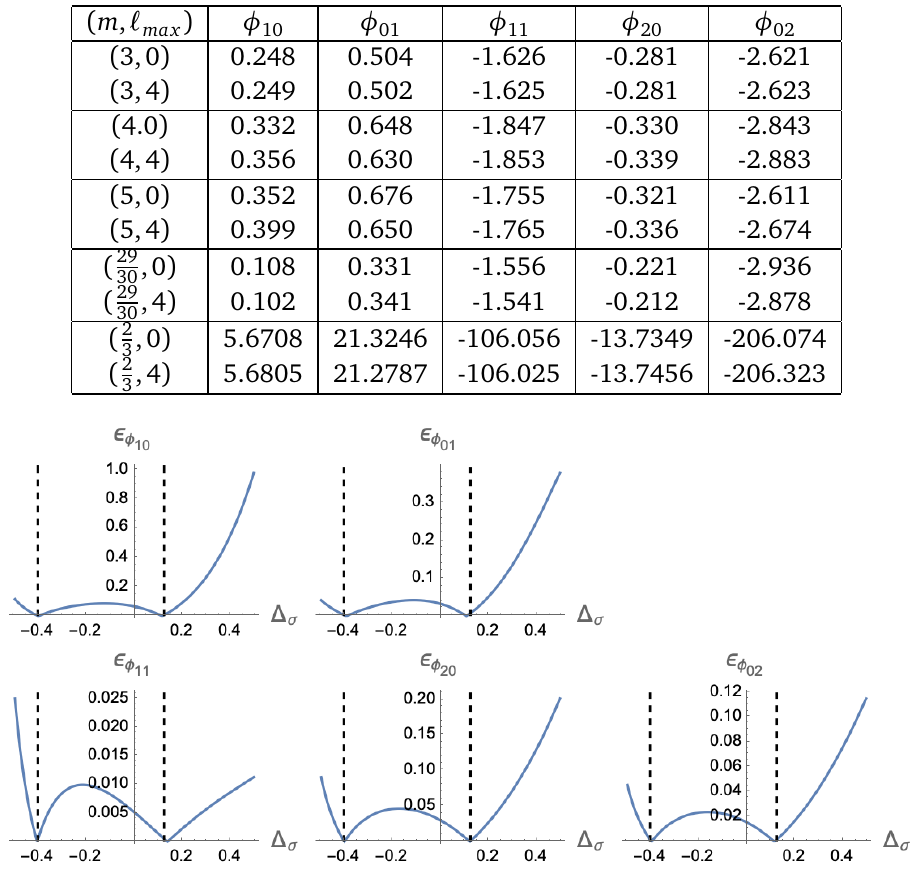
Table 3: φ ’s using CSDR eq.(3.28). First line in each row is using only the ε oper- pq ator.